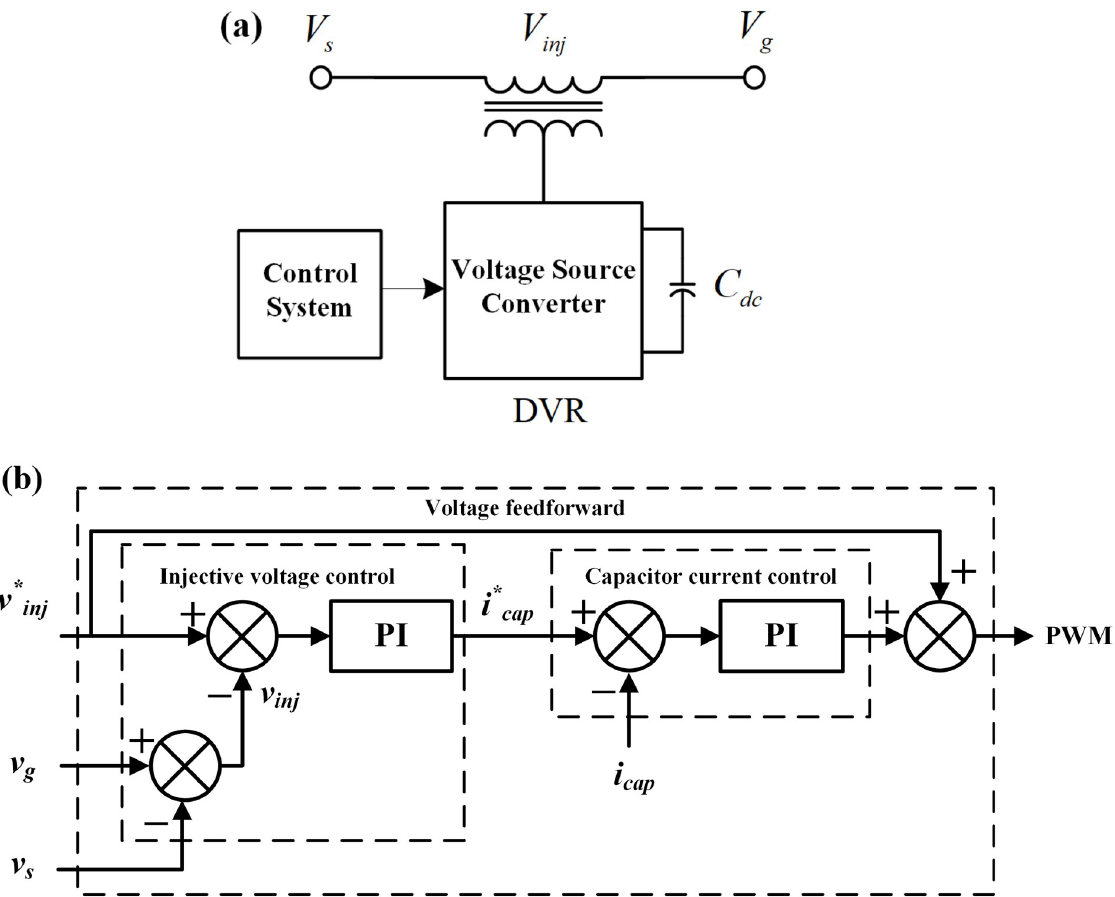
Fig 3. Description of the DVR. (a) Schematic, (b) control block diagram.